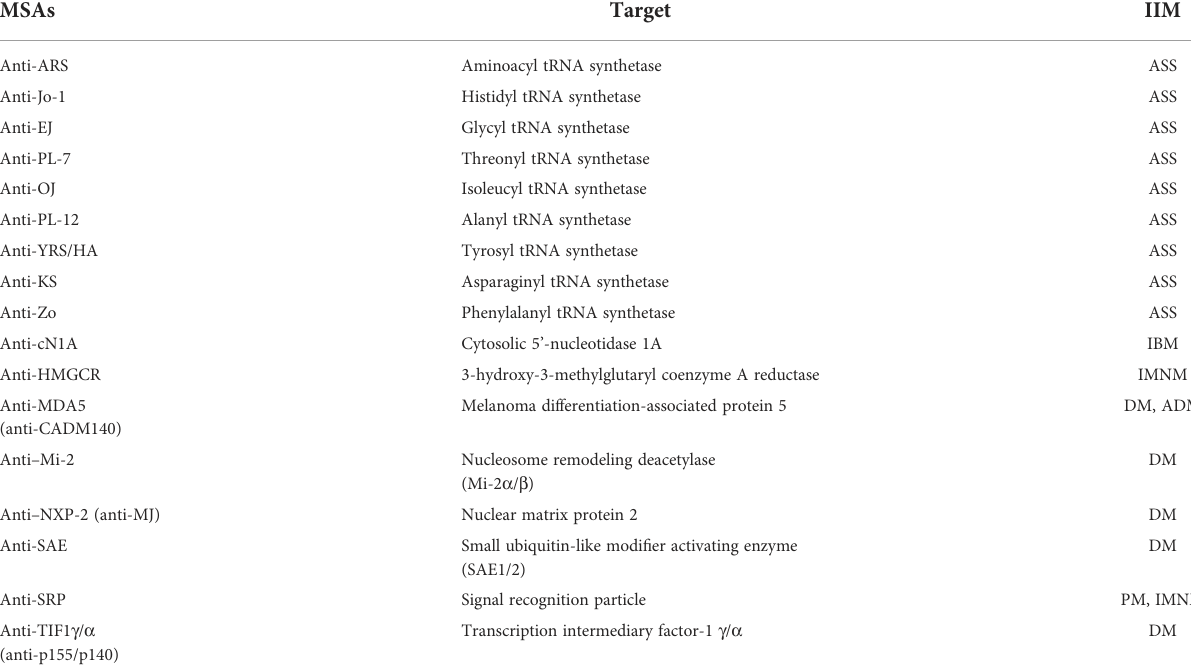
TABLE 1 Strati fi cation of Idiopathic In fl ammatory Myopathies patients according to myositis-speci fi c